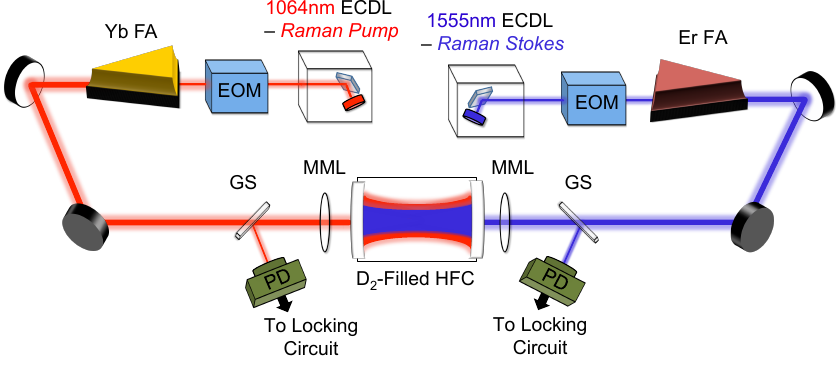
Figure 4. Simplified schematic for the two-beam experiment. We start with two external cavity diode lasers at the pump and at the Stokes wavelengths. Each beam is amplified to an output power of 20 W using a fiber amplifier. The amplified beams are then coupled to the high-finesse cavity using mode matching lenses. We use the Pound–Drever–Hall technique to lock the amplifier outputs to the cavity. ECDL: external cavity diode laser, EOM: electro-optic modulator, Yb FA: ytterbium-doped fiber amplifier, Er FA: erbium-doped fiber amplifier, GS: glass slide, MML: mode matching lens, PD: photo-diode,